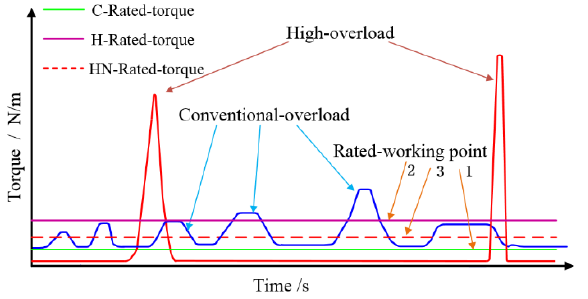
Figure 1. Operating conditions of conventional motor and short-term high-overload permanent magnet synchronous motor (STHO-PMSM).